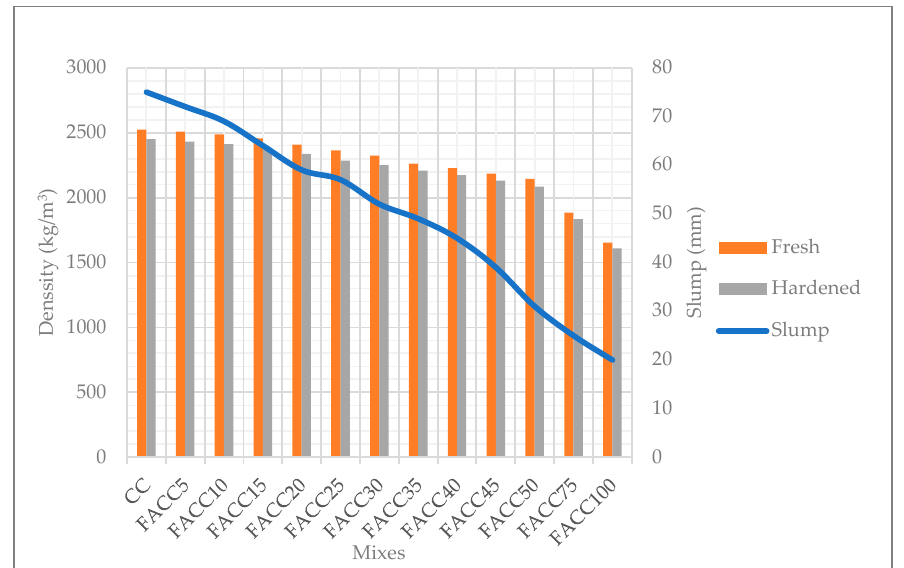
Figure 4. Fresh and Hardened Density of CC and FACC along with Slump.